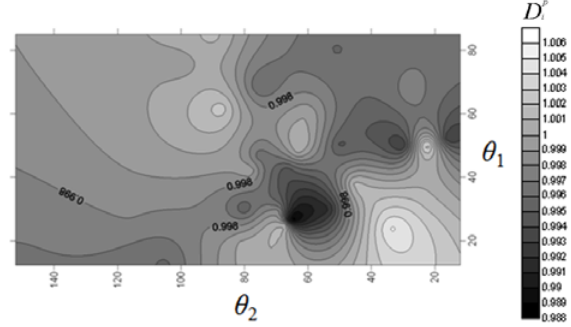
p , θ and D ,i at Re = 1 2 D